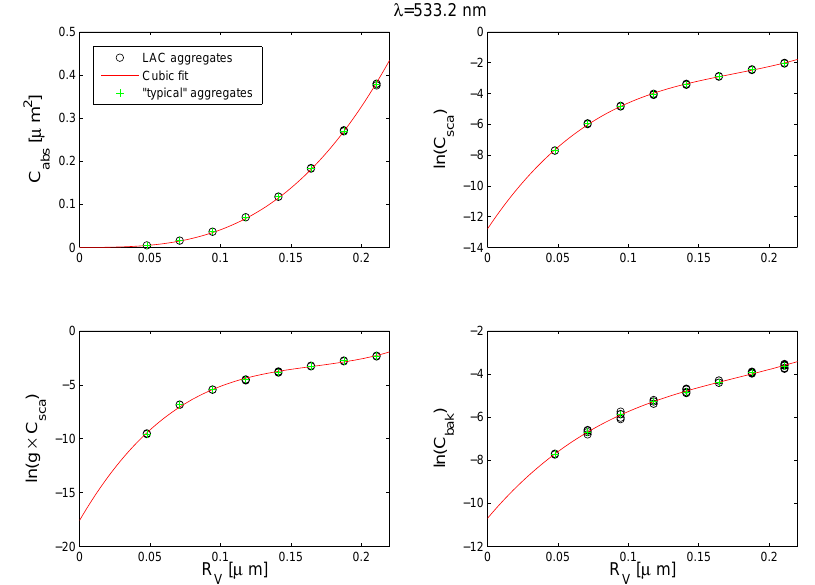
Fig. 2. C abs (upper left), C sca (upper right), g × C sca (lower left), and C bak (lower right) computed for five different model geometries (circles) at λ = 533 . 2nm. The green pluses denote results obtained for “typical” model geometries as explained in the text. The fitting curves are explained in the next